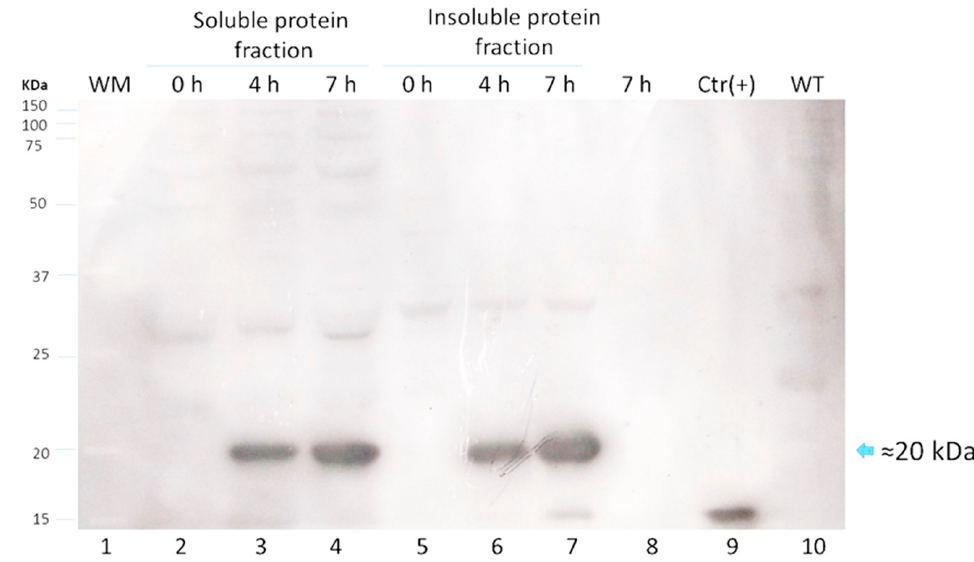
Figure 4. Western blot analysis for LTB-RBD Wuhan using anti-cholera toxin B subunit (CTB) serum to analyze protein extracts from cultures induced for 4 or 7 h at 28 ◦ C with lactose as inducer (lanes 2 to 4: soluble protein fraction and lanes 5 to 7: insoluble protein fraction). Lane 1: molecular weight marker, lanes 2 and 5: uninduced cultures, lanes 3 to 6: cultures induced for 4 h, lanes 4 and 7: cultures induced for 7 h, lane 8: culture medium supernatant, lane 9: cholera toxin subunit (CTB) used as positive control, and lane 10: soluble fraction of an untransformed